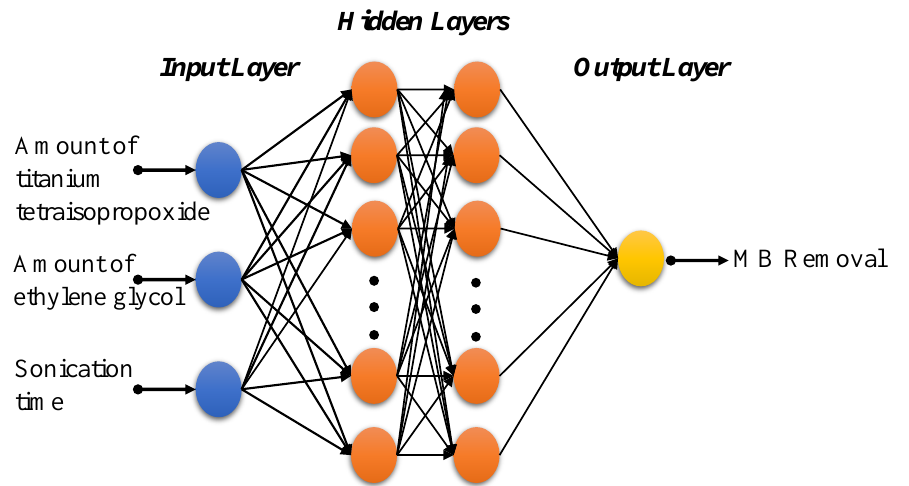
Figure 2. DNN model for the prediction of of the removal of methylene blue dye under the influence of nano TiO 2